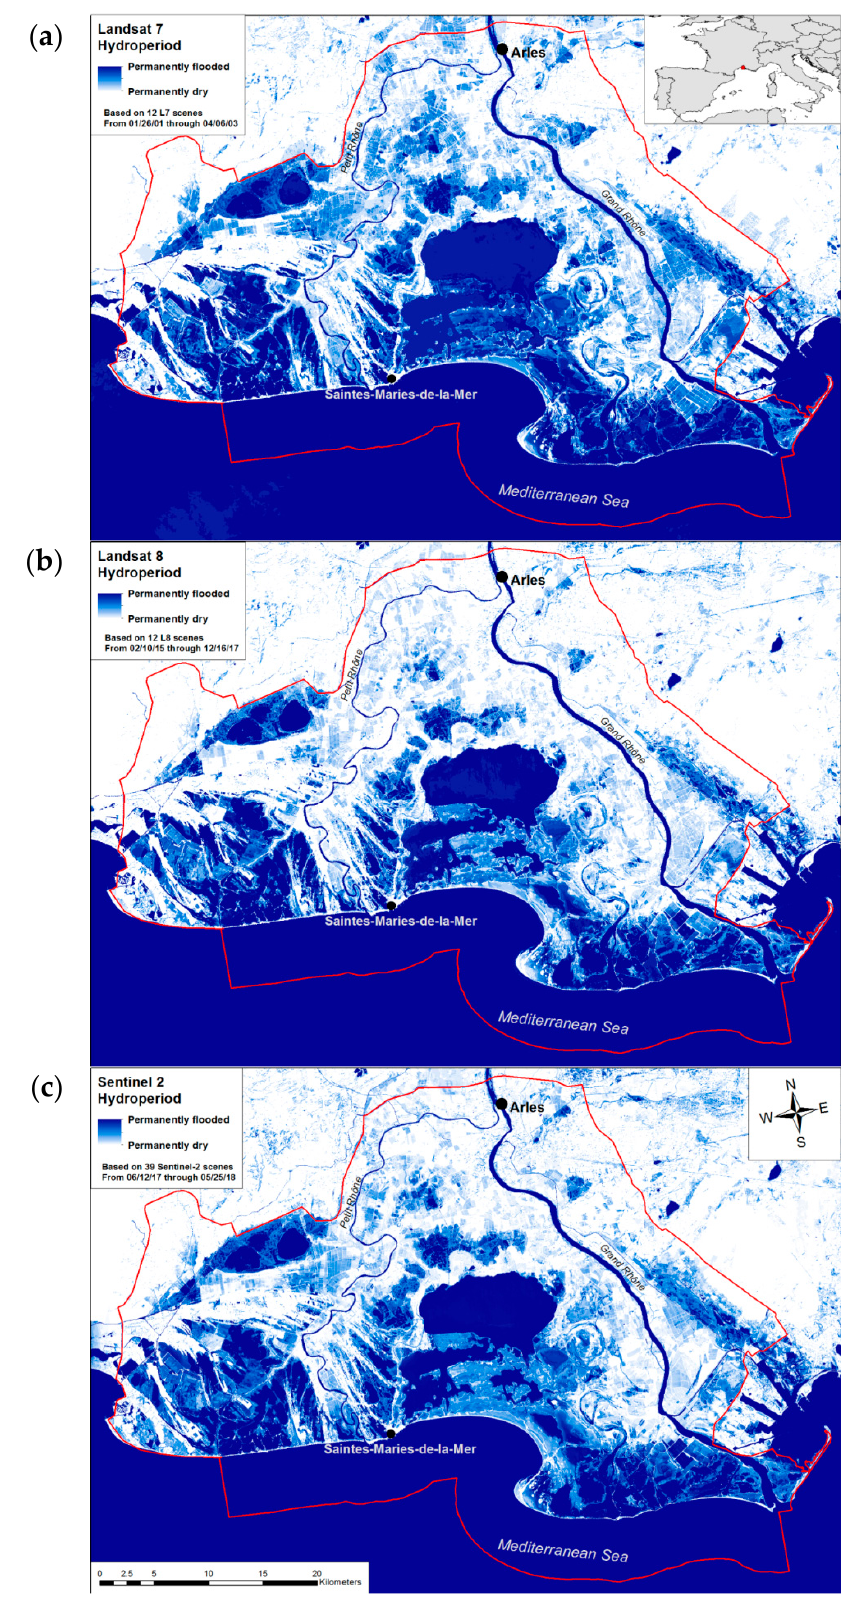
Figure 3. Annual water masks resulting from application of the WIW logical rule on ( a ) Landsat 7, ( b ) Landsat 8 and ( c ) Sentinel 2 satellites.